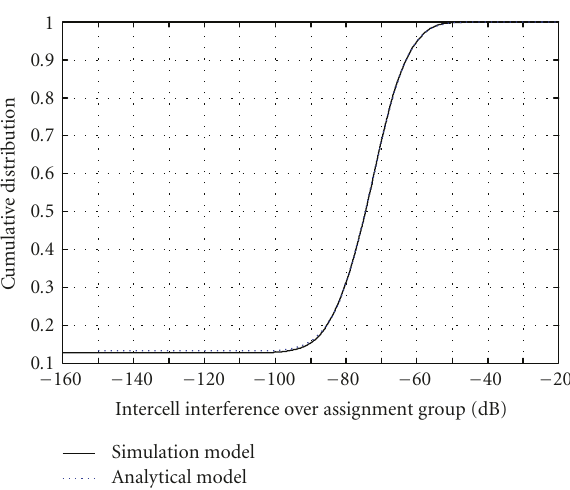
Figure 2: Probability distribution Q (1) ( n ) of number of users per assignment group in a 3-cell network.